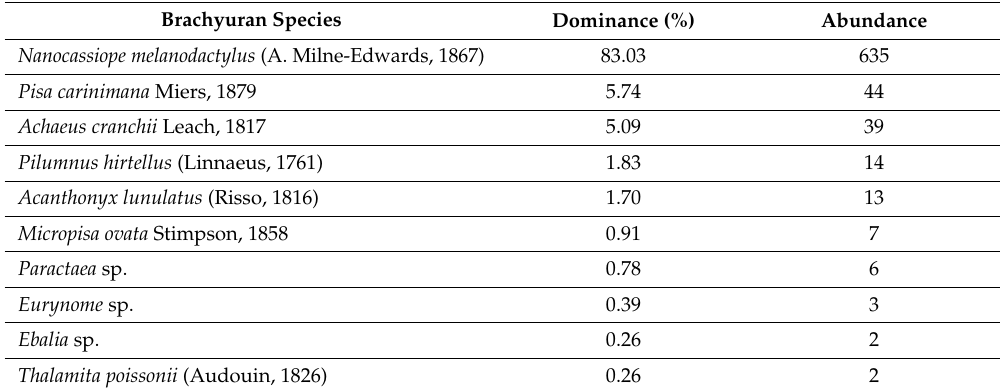
Table 1. Total abundance (dominance, as a proportion of the total) and number of individuals of each species for the overall study ( n = 120